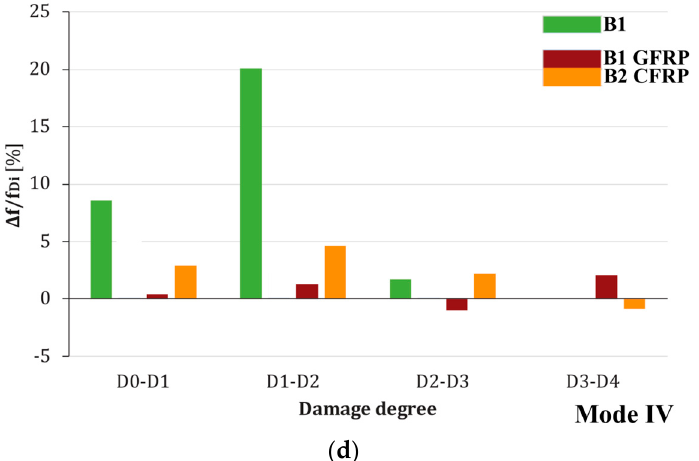
Figure 15. Comparison between frequency variation of beam models, at damage D i +1 , compared to D i , for the first four vibration modes: ( a ) mode 1; ( b ) mode 2; ( c ) mode 3; ( d ) mode 4.